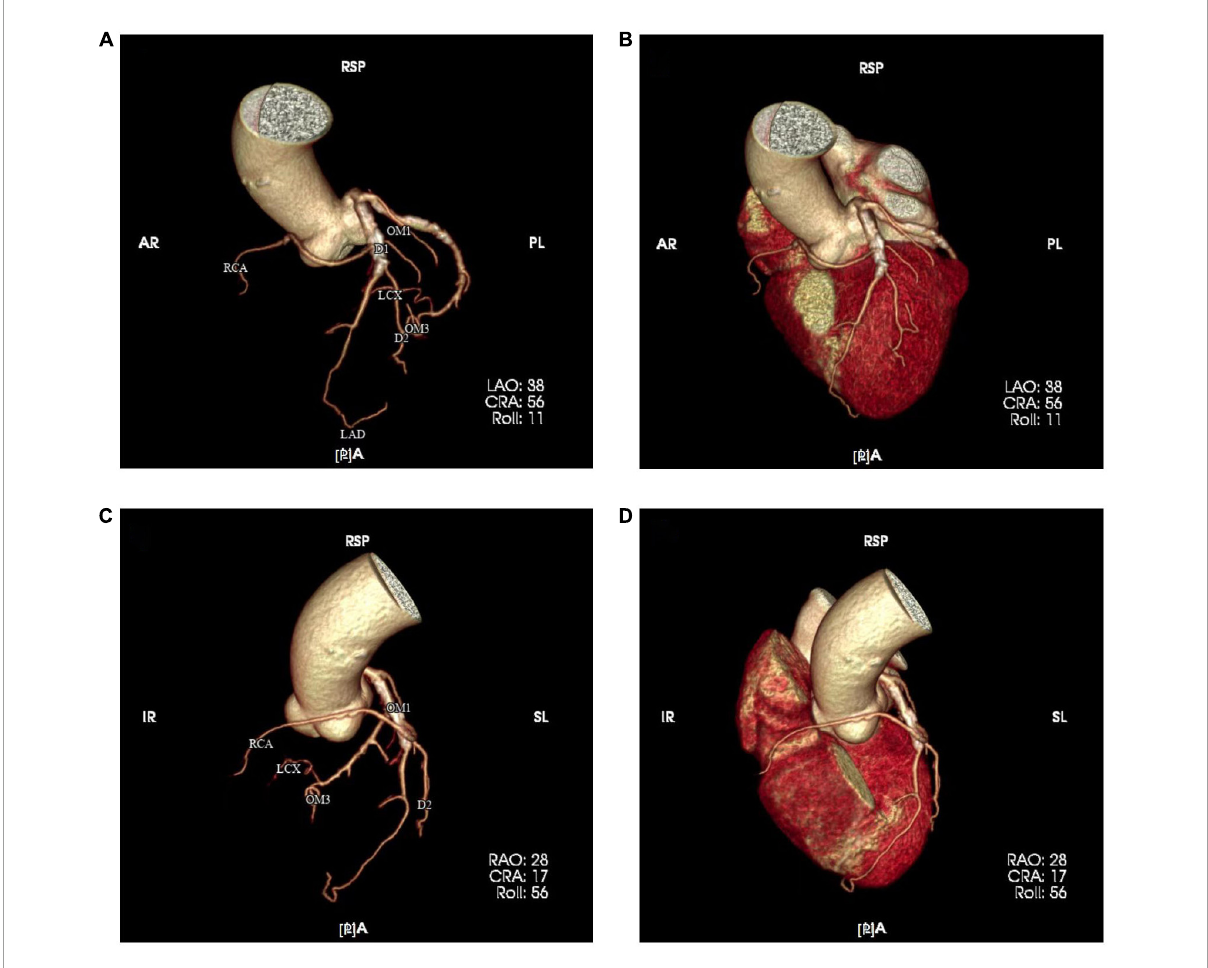
FIGURE3 Coronary computed tomography angiography (CTA) was re-examined one month after PCI and resulting images (A–D) confirmed the anomalous origin of the right coronary